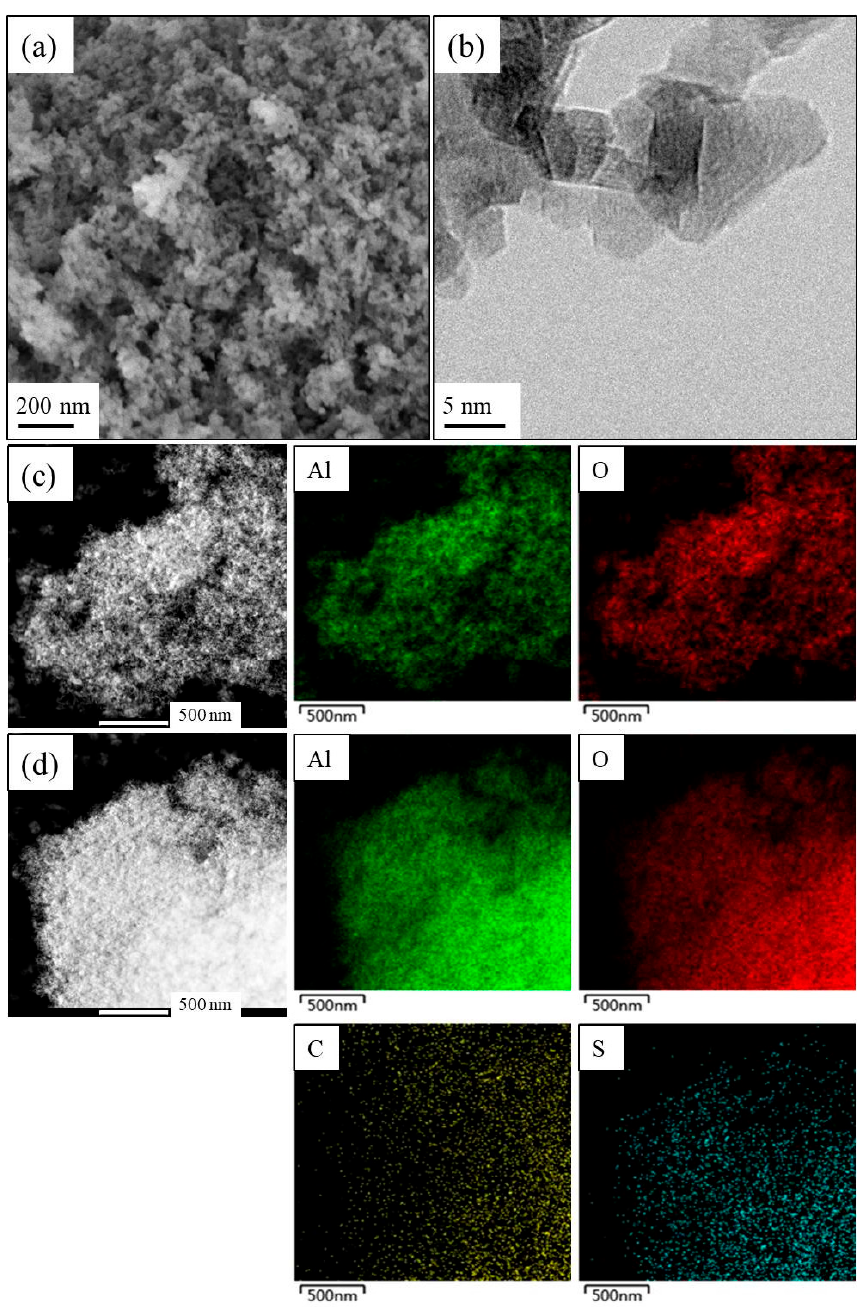
Figure 1. ( a ) SEM and ( b ) TEM images of UPA( θ ) powders, and elemental mapping of UPA( θ ) powders ( c ) before and ( d ) after RBBR adsorption.